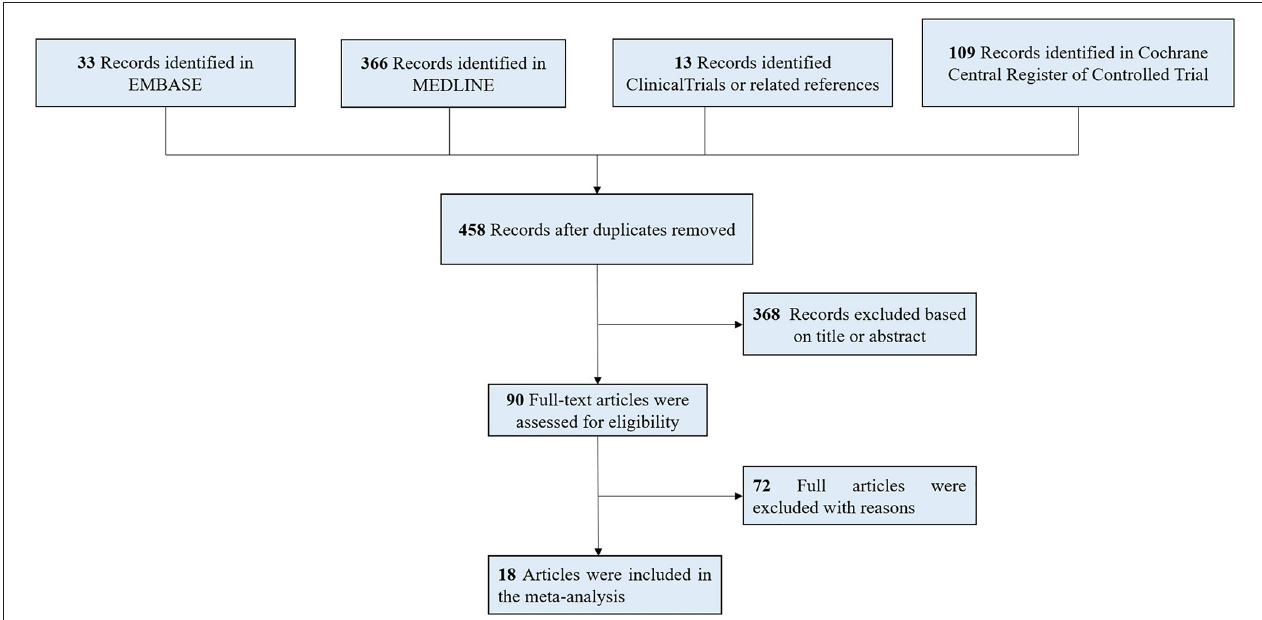
FIGURE 1 | Flow of the search strategy and included